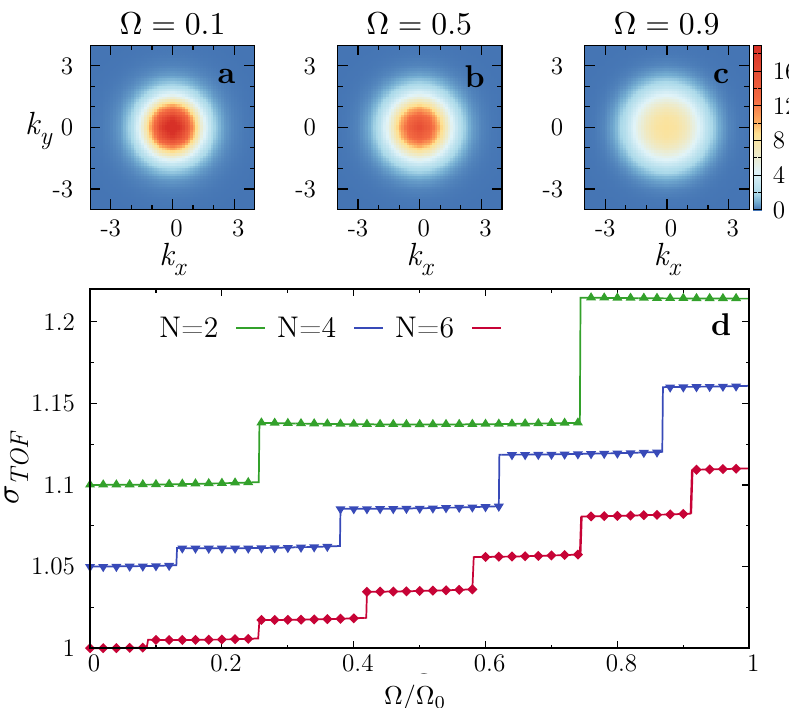
Figure 3: a-b-c Density plot of the TOF expansion for different values of the artificial = 11 lattice sites. d Renormalized gauge field in a system of N = 4 particles and N s /σ ( Ω = 0 ) of the time of flight density distribution, n ( k ) . Green data width σ TOF TOF are for N = 2 and U / J = − 3, blue for N = 4 and U / J = − 1 and red for N = 6 and U / J = − 0.6. For the sake of graphical clarity, each curve is offset by 0.05. Note